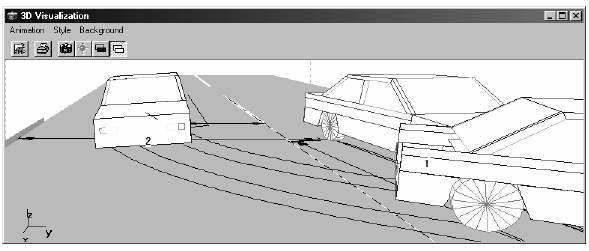
Fig 8 reflects the modelled collision of the auto- mobiles TOYOTA CELICA and NISSAN SUNNY.